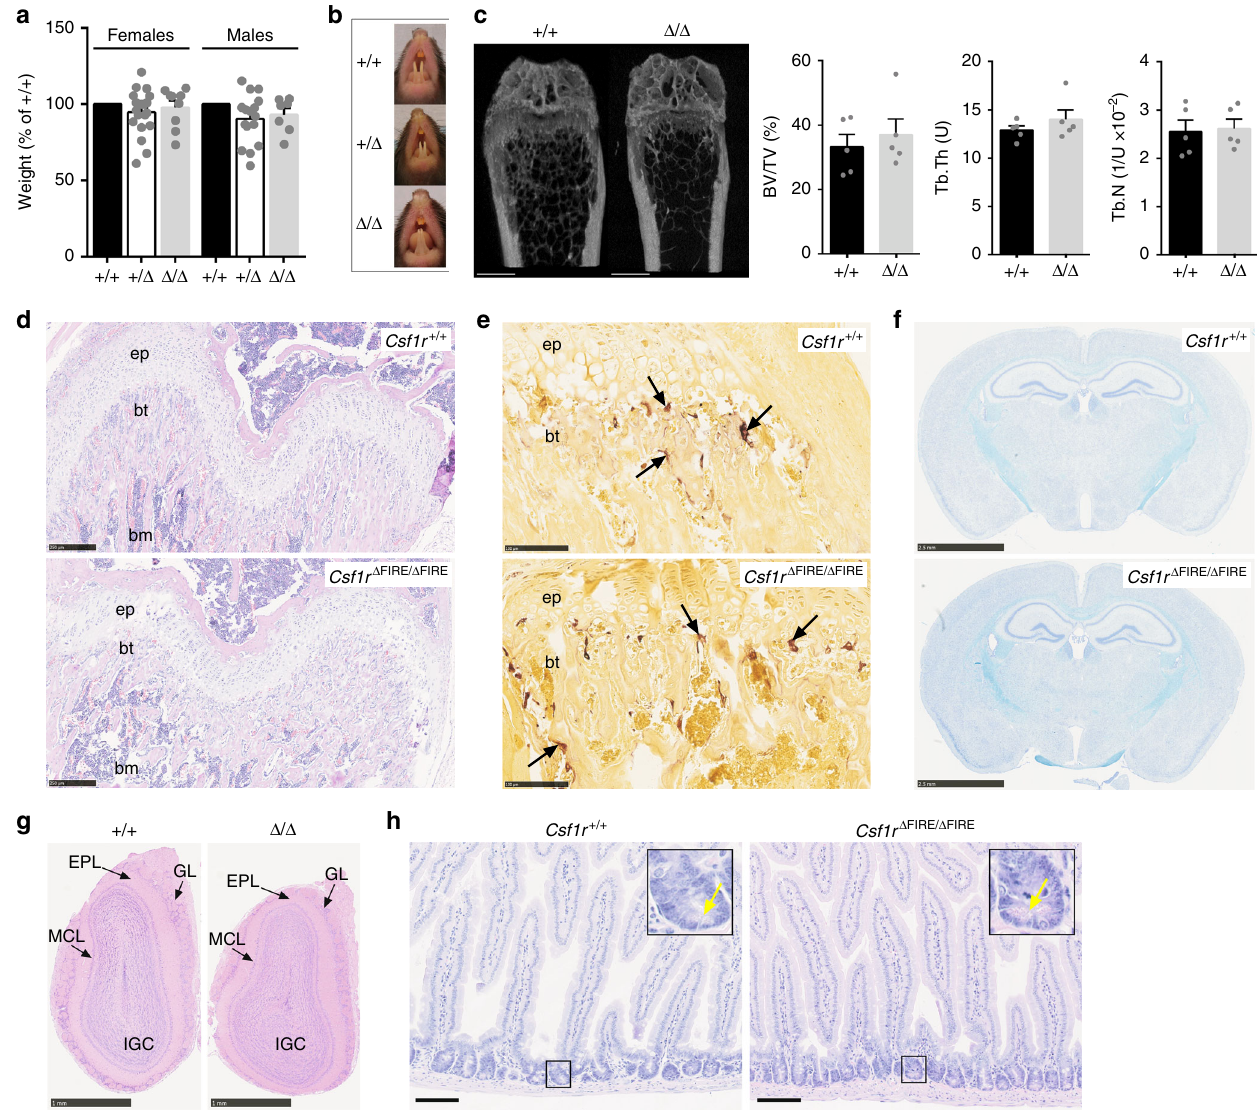
Fig. 2 FIRE-de fi cient mice displayed none of the gross phenotypes found in Csf1r − / − -mice. a Mice were weighed between 2 and 11 weeks of age. n = 7, 20, 9 (females) and 5, 16, 7 (males) for + / + , + / Δ , and Δ / Δ , respectively. b Representative images of tooth eruption in adult mice. c Femurs from 4-week-old male and female mice were scanned by Micro-CT. Scale bars = 1 mm. n = 5 mice per genotype. BV/TV bone volume over total volume (bone density), Tb. Th trabecular thickness, Tb.N trabecular number. d Hematoxylin and eosin (H&E) staining of sections of bone. Images are representative of six mice per genotype; ep epiphyseal plate, bt bony trabeculae, bm bone marrow. Scale bar = 250 µ m. e Femurs from the same cohort of mice above were stained for tartrate-resistant acid phosphatase (TRAP). Arrows point to TRAP + osteoclasts. Scale bar = 100 µ m. f Luxol Fast Blue staining of paraf fi n-embedded formalin- fi xed adult brains. Images are representative of three mice per genotype. Scale bar = 2.5 mm. g H&E staining of olfactory bulbs from adult mice. Images are representative of six mice per genotype. EPL external plexiform layer, GL glomerular layer, IGC internal granular cell layer of the olfactory bulbs, MCL mitral cell layer. Scale bar = 1 mm. h H&E staining of sections of duodenum from adult mice. Yellow arrows point to Paneth cells. Images